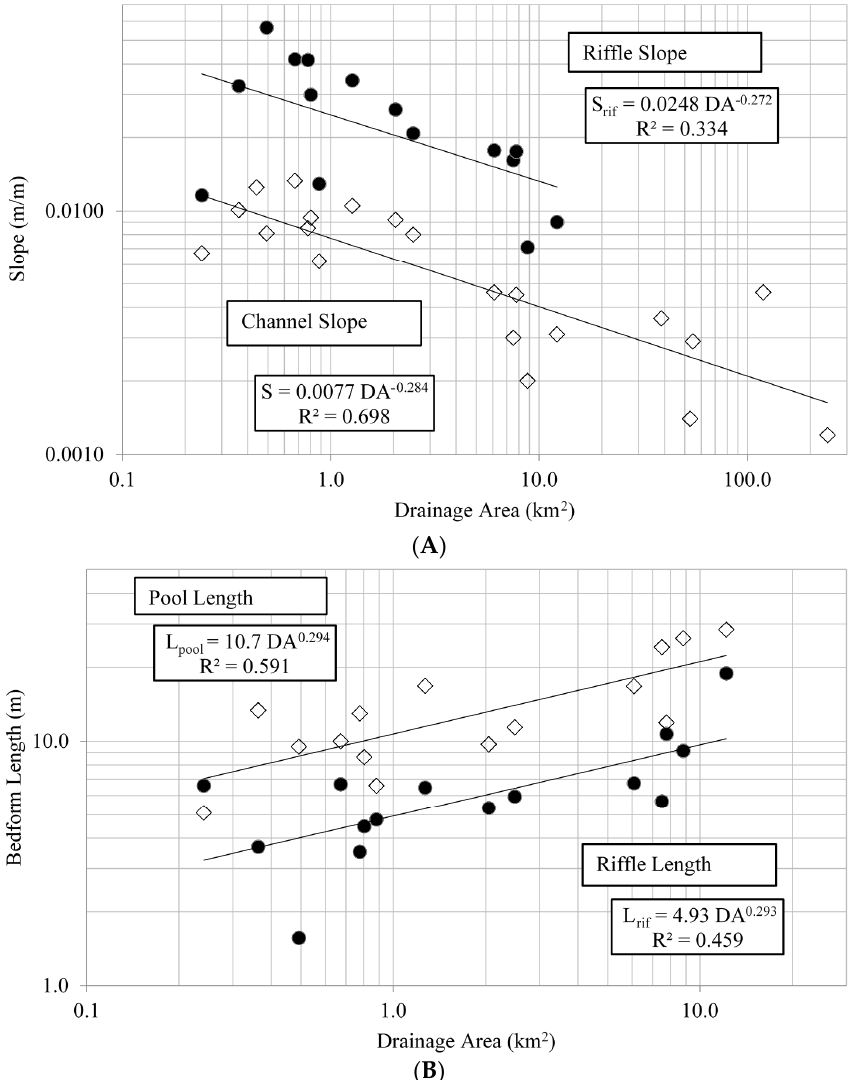
Figure 3. Slope ( A ) and bedform ( B ) relationships with drainage area for Alabama Piedmont reference streams. All slope and bedform variables are related to drainage area by the power model y = ax b , where y is the bedform measure and x is drainage area, a is slope and b is model parameter.